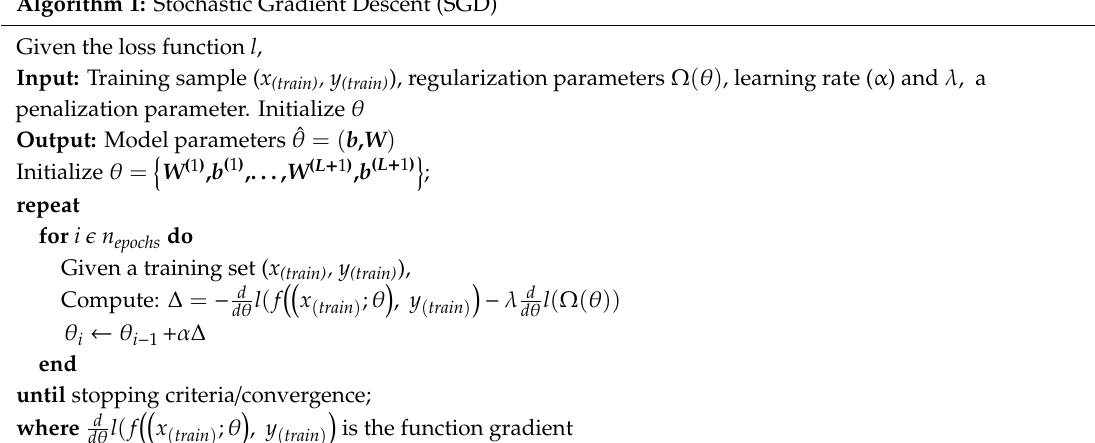
Algorithm 1: Stochastic Gradient Descent (SGD) Given the loss function l,